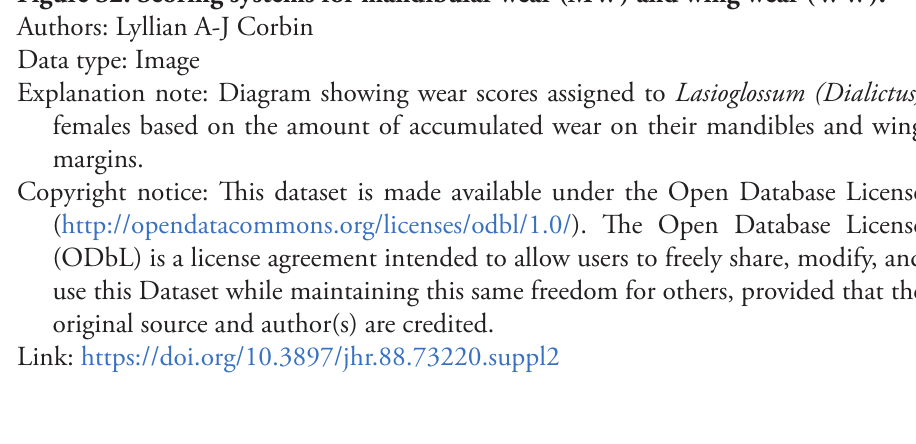
Figure S2. Scoring systems for mandibular wear (MW) and wing wear (WW). Authors: Lyllian A-J Corbin Data type: Image